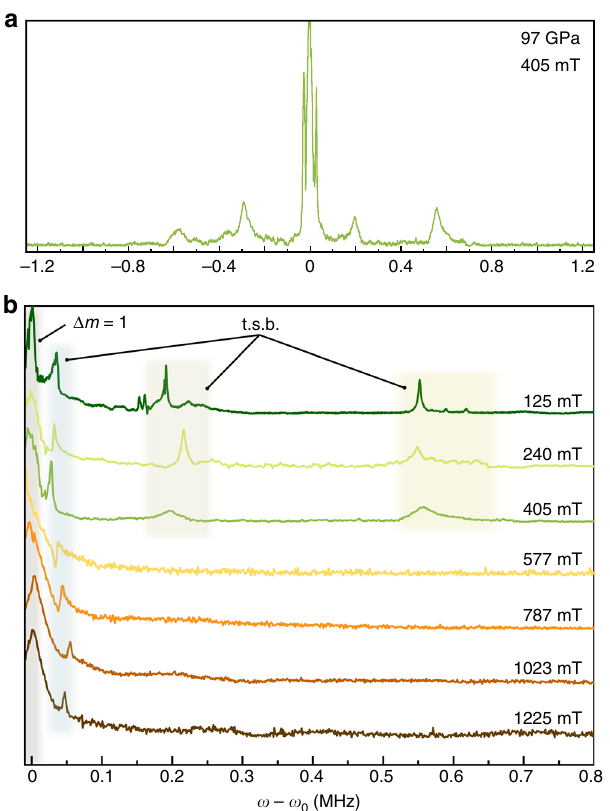
Fig. 5 Low fi eld NMR spectra of Ice X at 97 GPa. a Full 1 H-NMR spectrum at a magnetic fi eld of 405 mT, centered around the magnetic ( Δ m = 1) signal. b High- fi eld side of the 1 H-NMR spectra between 125 and 1225mT. Colored regions indicate the positions of the Δ m = 1 signals, as well as tunneling side bands